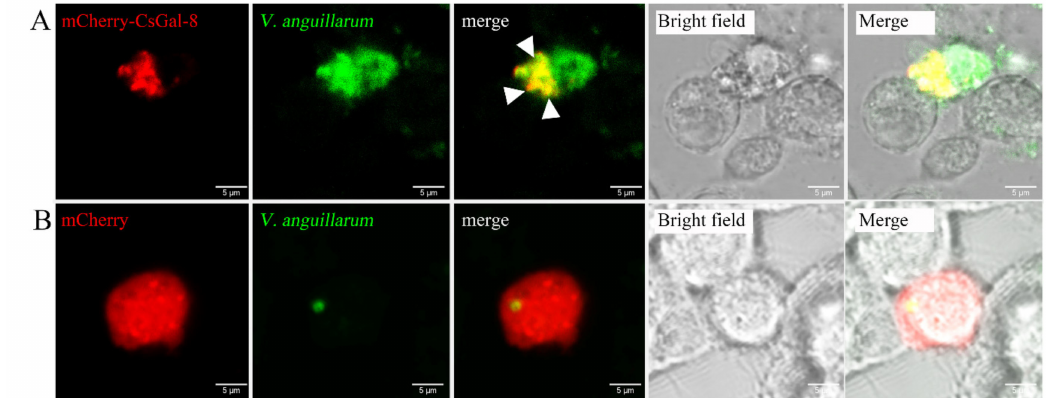
Figure 6. Co-localization of CsGal-8 with Vibrio anguillarum . RAW264.7 cells transfected with the vector expressing mCherry- tagged CsGal-8 ( A ) or the backbone vector ( B ) were incubated with FITC-labeled V. anguillarum for 2 h. The cells were then observed with a confocal microscope. Co-localization of CsGal-8 and V. anguillarum is indicated by